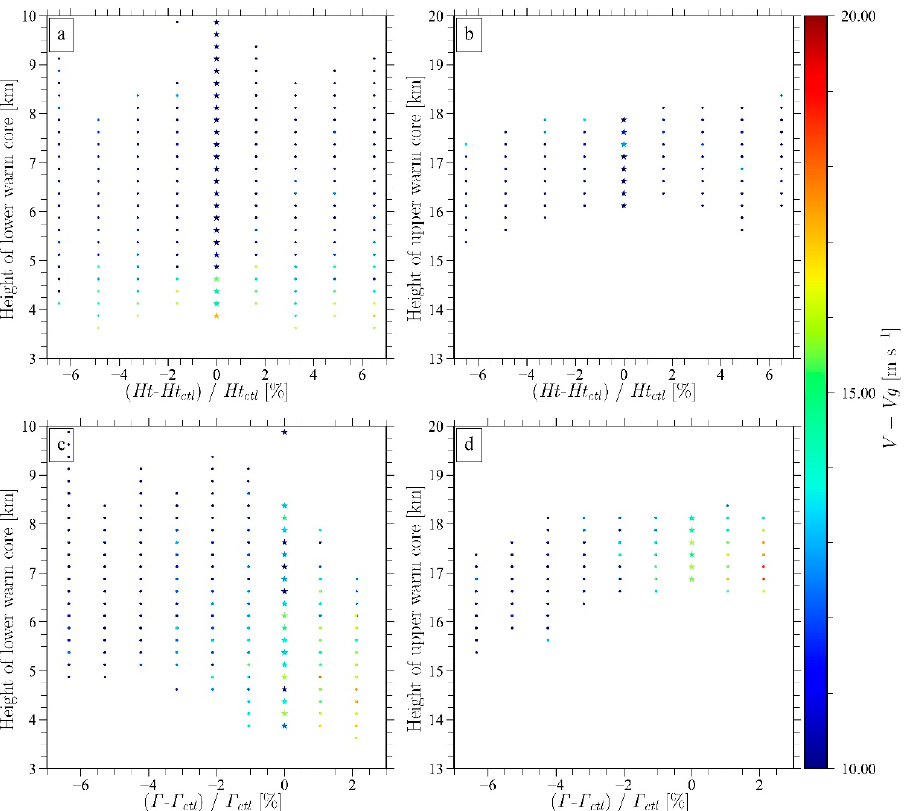
Figure 10. The same as Figure 9, except showing the relationships of the tropopause height and the temperature anomaly with the heights of the lower and upper warm